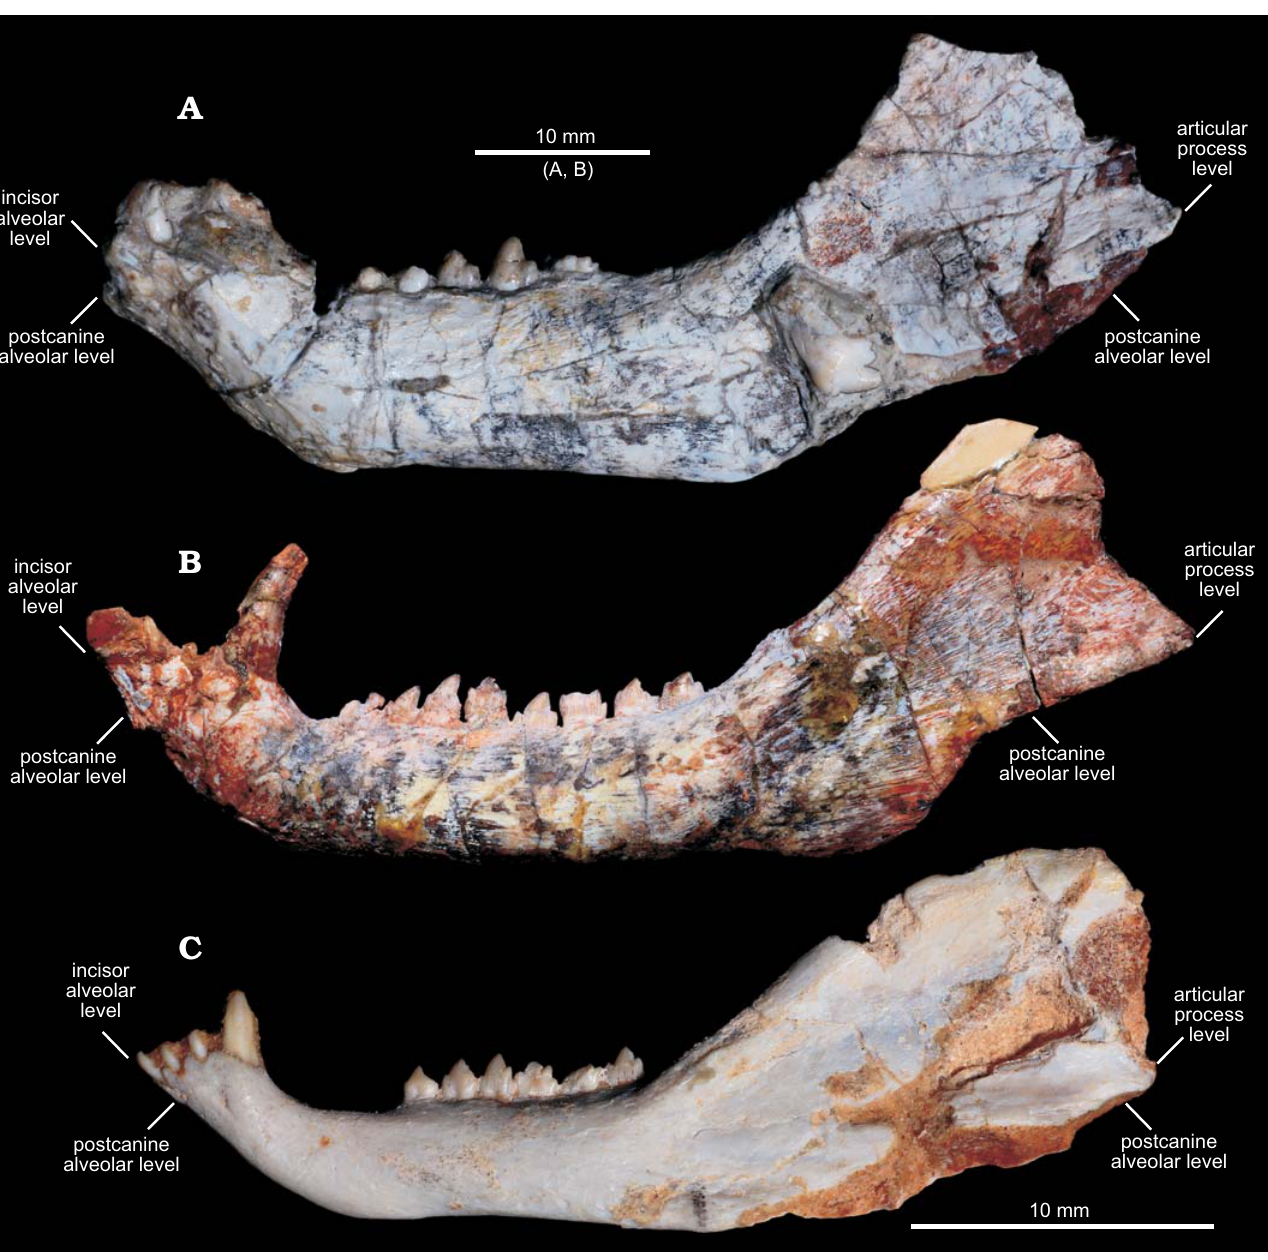
Fig. 3. Comparisons of dentaries of selected cynodonts in lateral view. A . Left dentary of Candelariodon barberenai Oliveira, Schultz, Soares, and Rodrigues, 2011 from the Middle–Late Triassic of Rio Grande do Sul state, Brazil (holotype, MMACR PV-0001-T). B . Right dentary (inverted) of Prozostrodon brasiliensis (Barberena, Bonaparte, and Teixeira, 1987) from the Late Triassic of Rio Grande do Sul state, Brazil (holotype, UFRGS-PV- 248-T). C . Left dentary of Brasilitherium riograndensis Bonaparte, Martinelli, Schultz, and Rubert, 2003 from the Late Triassic of Rio Grande do Sul state, Brazil (UFRGS-PV-1043-T). Abbreviations: aple, articular process level; ile, incisor alveolar level; pcle, postcanine alveolar